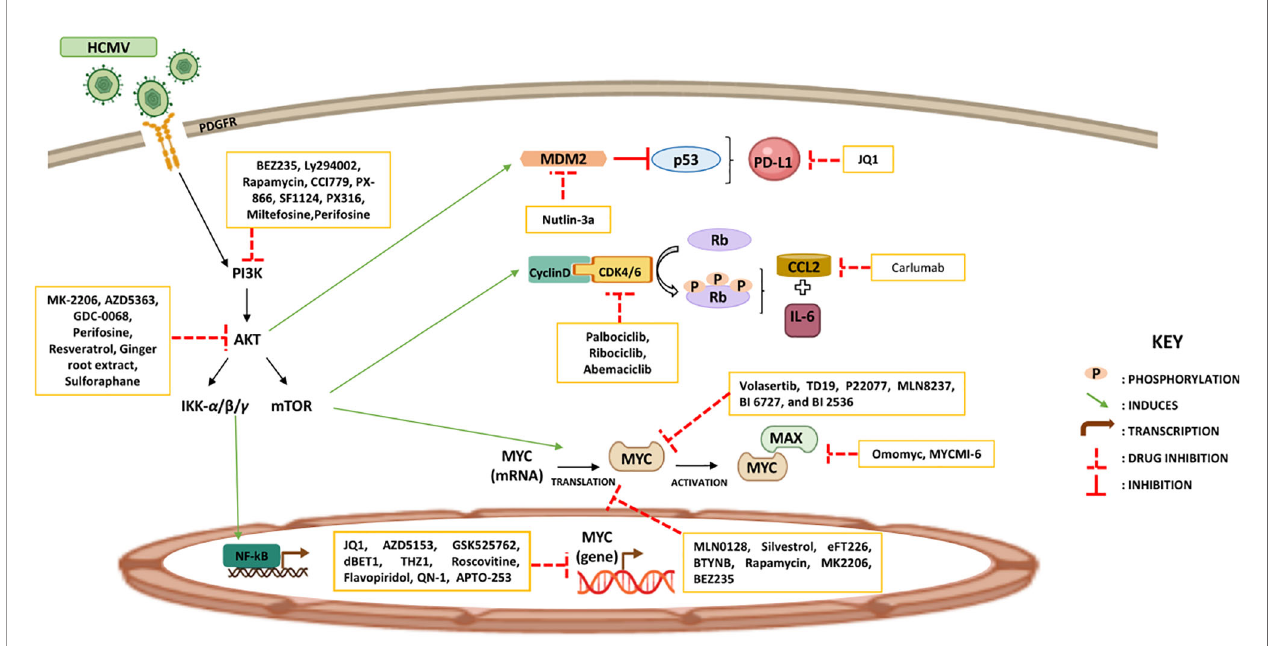
FIGURE 3 | Potential therapeutic approaches reinstating tumor immunity. Certain therapeutic strategies are used to increase tumor suppressor proteins and reduce oncoproteins ’ expression with the aim of restoring the immune response against